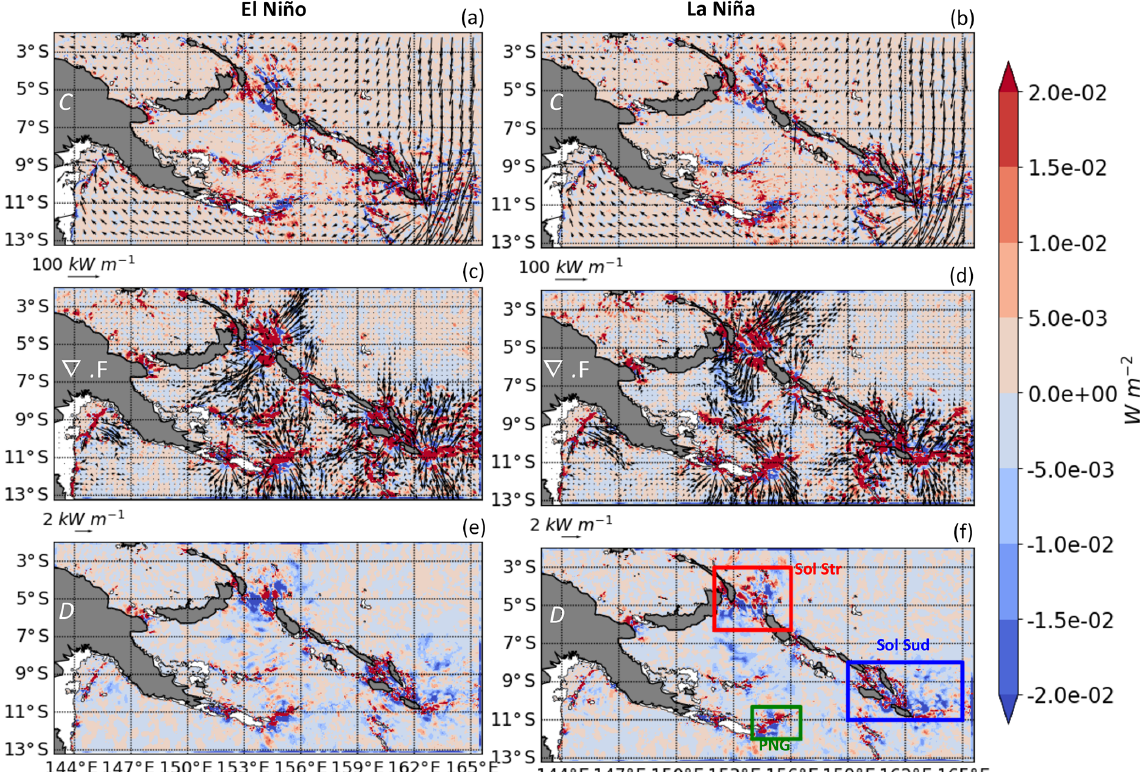
Figure 9. (a, b) Conversion rate ( C ), (c, d) the baroclinic flux divergence ( ∇ F ), and (e, f) the dissipation rate ( D ) for the M2 harmonic (negative values shaded in blue; positive values in red; unit: watts per square meter). The corresponding barotropic and baroclinic energy flux are superimposed with arrows in (a) – (d) , with a scaling of 100 and 2kWm − 1 , respectively. Panels (a) , (c) , and (e) correspond to the El Niño period and panels (b) , (d) , and (f) to the La Niña period. The boxes define the different generation areas where energetics are quantified in Table 1. Isobathymetric lines are from the NOAA/ETOPO2v2 bathymetric file from the Smith & Sandwell database (https: